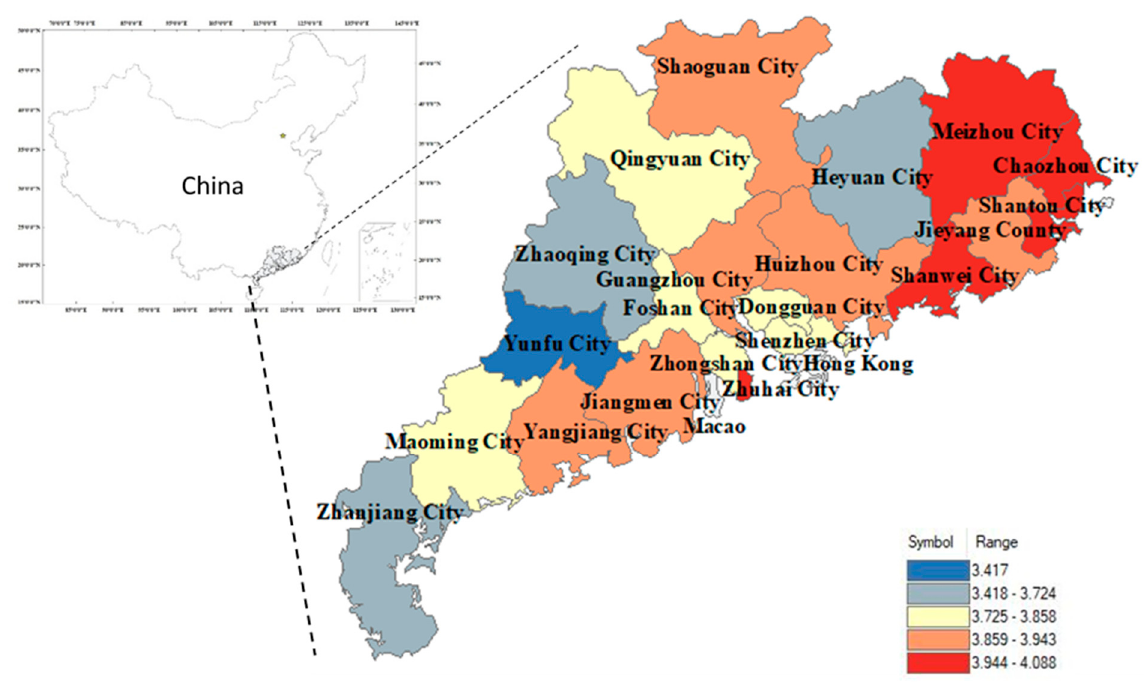
Figure 3. The mean score of SI reported in Guangdong, 2018.